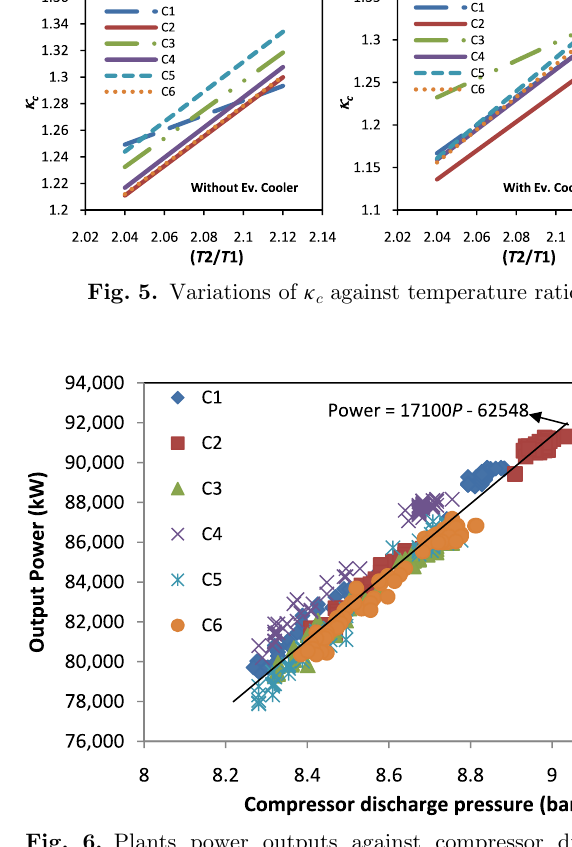
Fig. 6. Plants power outputs against compressor discharge